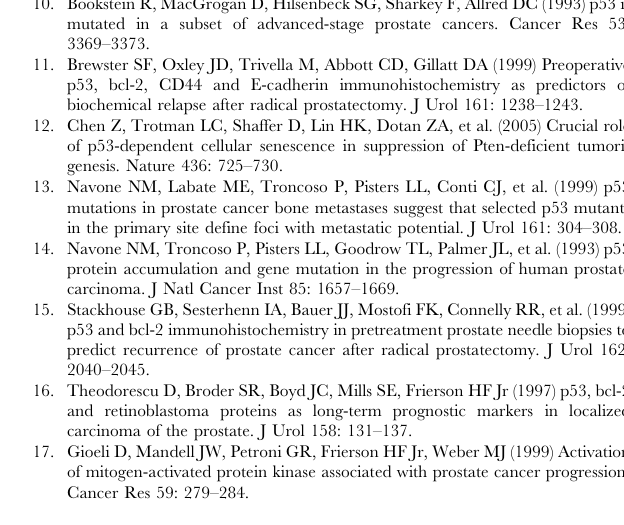
MRI images. For comparison, serial imaging of a WT mouse was shown. Asterisks indicate two post-castration tumors containing prostatic tumor cells on histological examination. Figure S5 Activation of B-RAF pathway is not required for tumor progression and maintenance. A. Schematic representation of CI-1040 (a MEK inhibitor) treatment protocol using tissue recombination. Tissue recombinants were generated with iBRAF* prostate cancer cells and rat mesenchymal cells, implanted under the kidney capsule of nude mice, and grown for 2 months. The mice were orally treated with CI-1040 at 150 mg/kg body weight twice a day for two weeks. B. Gross morphology and graft weight after two-week treatment showed significantly increased graft size with CI-1040 treatment, compared to mock-treated control (p = 0.032). C. Histological analyses of grafts from mock-treated and CI-1040-treated mice confirmed prostate tumor development. Although decreased p-ERK staining with CI-1040-treated mice indicated the inhibition of B-RAF pathway, tumors were still proliferating, as manifested by strong positivity with Ki67 staining. Figure S6 Strong activation of p-ERK and p-S6K was also observed in human prostate tumors harboring BRAFV600E mutation (total 8 samples; n= 4 with WT BRAF and n= 4 with BRAFV600E mutation). Importantly, two of the four human prostate tumors harboring BRAFV600E mutation showed no activation (BRAF V600 # S04-7014) or very weak activation of p- AKT (BRAF V600 #